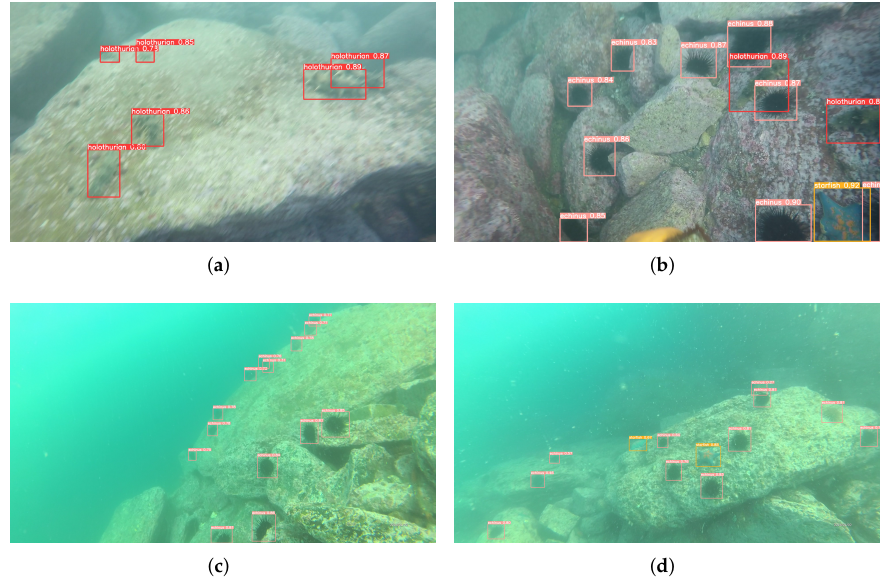
Figure 13. Single-class and multi-class target detection results in the case of blurred images at close and far distances, where different color squares represent different targets, the red squares represent holothurian, the pink squares represent echinus, the yellow squares represent starfish: ( a ) single-class of targets at close range; ( b ) multi-class of targets at close range; ( c ) single-class of targets at far range; ( d ) multi-class of targets at far range.